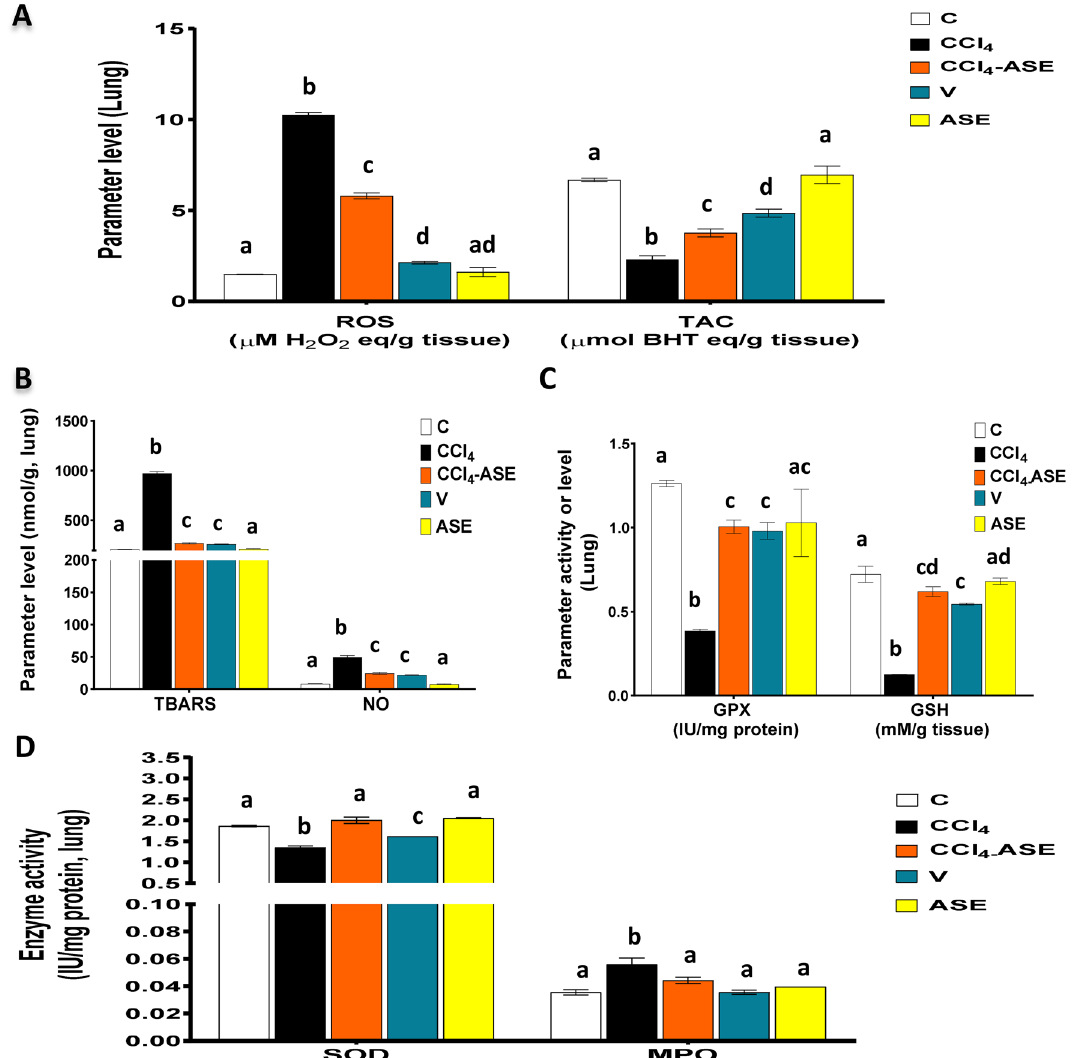
Figure 4. Ameliorating effect of ASE on the CCl 4 -induced redox state disturbance in the lung tissue. ( A ) reactive oxygen species (ROS) and total antioxidant capacity (TAC) levels. ( B ) thiobarbituric acid reactive substances (TBARS) and nitric oxide (NO) levels. ( C ) reduced glutathione (GSH) level and glutathione peroxidase (GPX) activity. ( D ) superoxide dismutase (SOD) and myeloperoxidase (MPO) activities. Results are expressed as mean ± S.E of 7 animals. BHT butylated hydroxytoluene, C control untreated rats, V olive oil (vehicle of CCl 4 )-administered rats (0.5 ml/kg b.w., ip, 6 times), CCl 4 rats with systemic toxicity induced by CCl 4 injection (1 mL/kg b.w., ip, 6 times), CCl 4 -ASE rats with systemic toxicity after their oral treatment with ASE (7.5 g/kg b.w.) for 10 days. ASE , normal rats were administered only ASE (7.5 g/kg b.w.) for 10 days. Different letters refer to the significance at P < 0.05, CCl 4 -ASE group was compared with the CCl 4 group, while V and ASE groups were individually compared with the C treatment with ASE after CCl 4 -injection (CCl 4 -ASE group) improved the redox state in lung tissue extremely. This was attributed to the significant ( P < 0.05) decrease in the studied oxidative stress parameters, ROS, NO, TBARS, and MPO levels, by 43.448%, 50.098%, 72.211%, 20.594%, respectively, compared to those in the CCl 4 group (Fig. 4A,B,D). Besides, ASE significantly ( P < 0.05) enhanced the lung antioxidant system (GPX, GSH, and SOD) by 160.157%, 386.431%, and 48.505%, relative to the CCl 4 group (Fig. 4C,D). These results led to an increase in the lung tissue TAC (64.683%) related to that in the CCl 4 group (Fig. 4A). On the other hand, the lung tissue of rats in the vehicle (V) group showed an alteration in the redox state parameters. Hence, ROS, NO, and TBARS were significantly ( P < 0.05) increased by 43.619%, 158.818%, and 24.490%, compared to the C group. Also, the antioxidant parameters, including GPX (22.390%), GSH (24.611%), and SOD (3.469%) were depleted significantly ( P < 0.05), and as a result, the TAC (27.389%) was decreased compared to the control group (Fig. 4A,C,D), while the activity of MPO in the lung of the rats in this group was insignificantly increased (0.456%), compared to that in the C group. Nevertheless, the administration of ASE alone for 10 days (ASE group) displayed non-significant changes in the studied oxidative stress parameters in